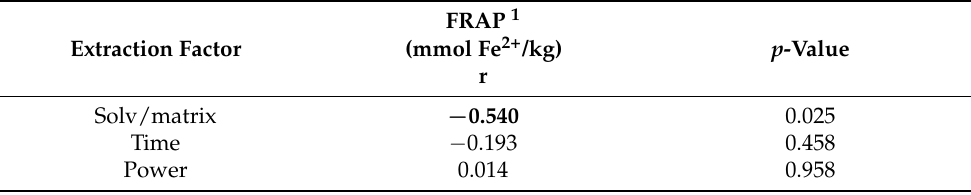
Table 4. Correlation analysis between FRAP values of the extract and the three factors: solvent/matrix ratio, time of extraction, and microwave power. Pearson’s correlation coefficient (r) and p -value of correlation (mean of three reps) are